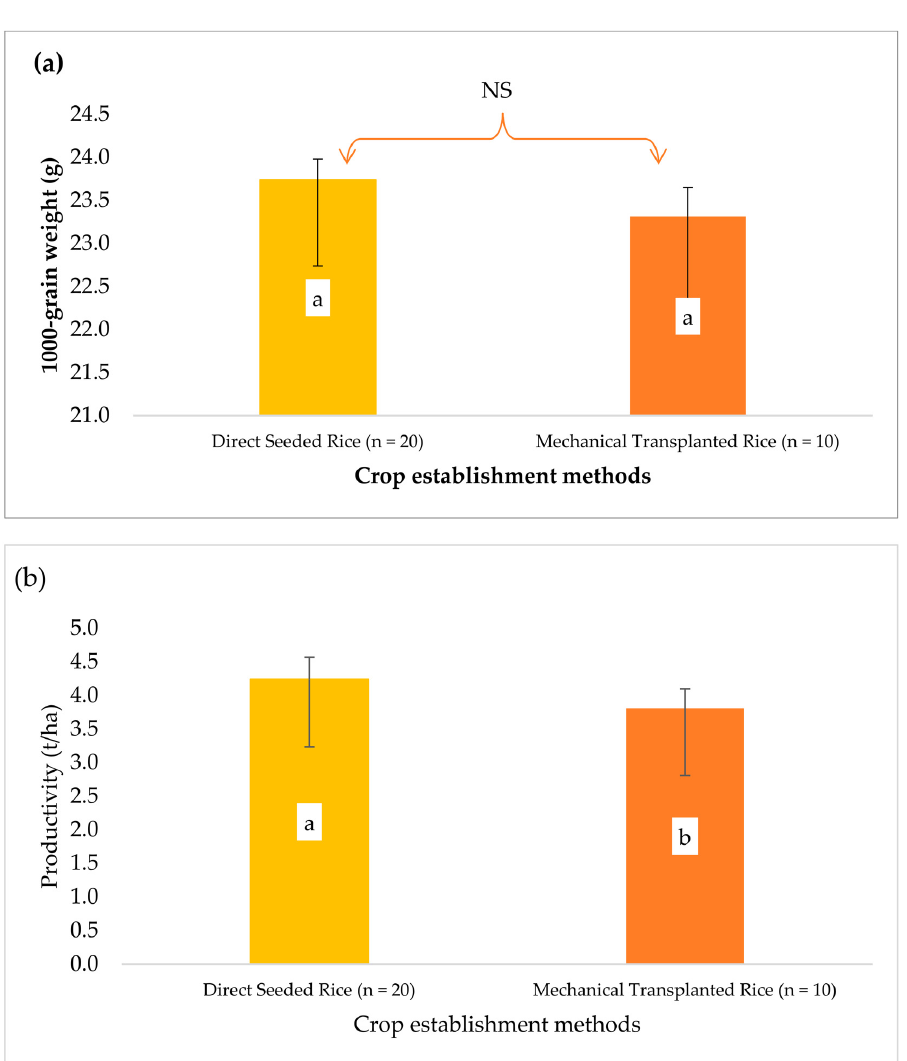
Figure 6. Effect of crop establishment methods on ( a ) 1000-grain weight and ( b ) rice productivity. Vertical bars for each column indicate standard deviation of the mean (for direct seeded rice n = 20 and in mechanically transplanted rice n = 10). Means of different land uses, followed by the different lowercase letters (a–b), are significantly